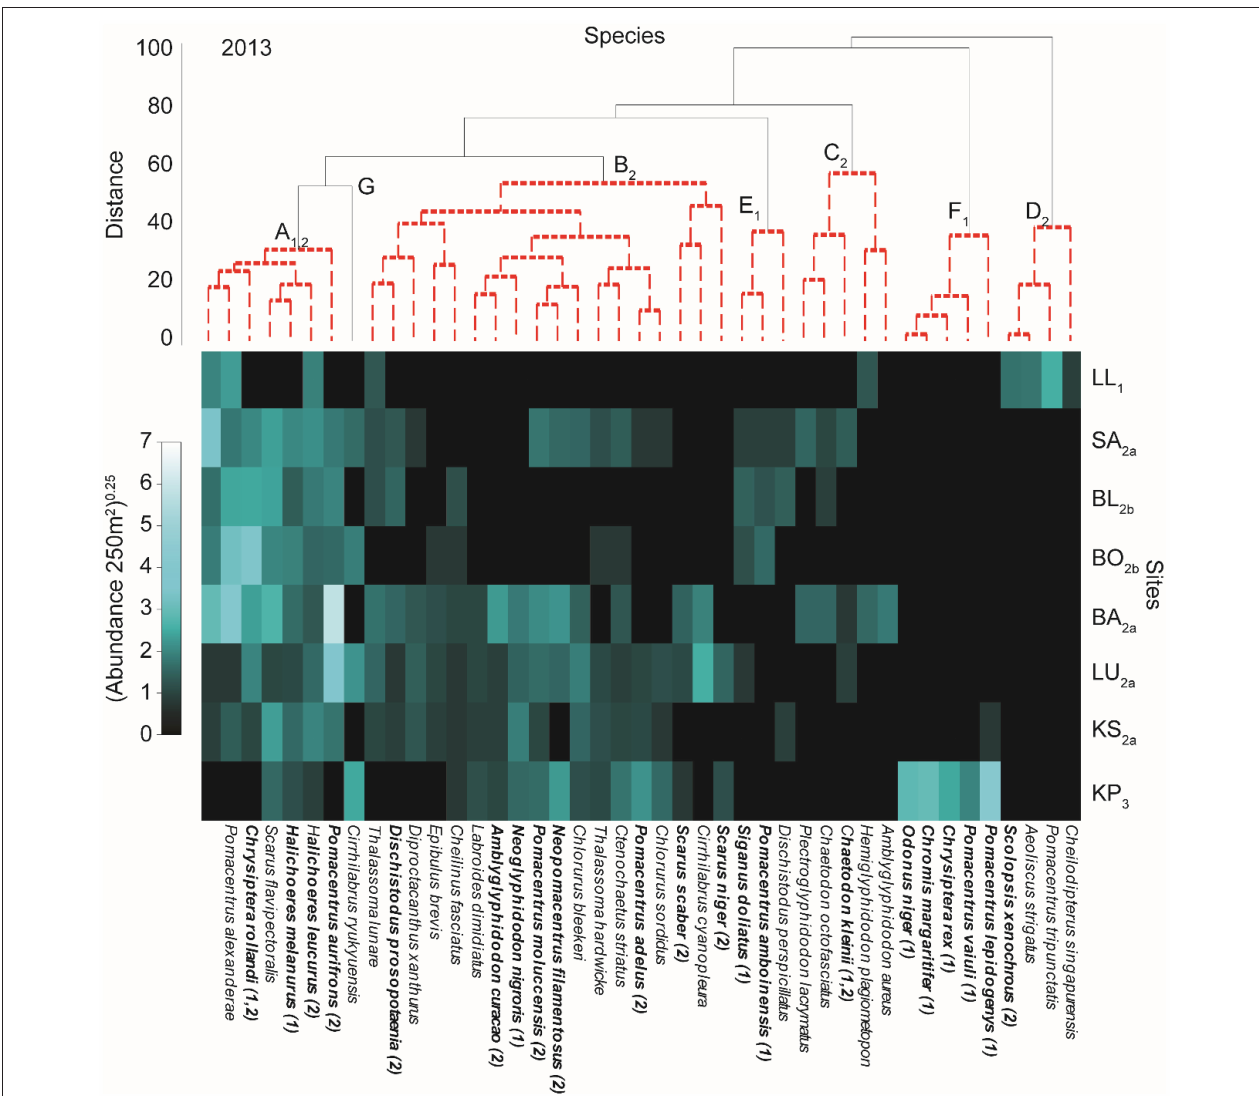
FIGURE 3 | Shade plot of relative species abundances in 2013. Results of cluster analysis showing significant groups (SIMPROF test) of species (capital lettering on species dendrogram and indicated with red dotted line) and sites (numbered subscript on site acronyms and identified in Supplementary Figure 1) with relative abundance of fish indicated in the shade plot. Sites are ordered from top to bottom increasing in distance from the mainland ( Figure 1 ). Subscript on species groups indicates a significant relationship with PCs of the benthic PCA (Supplementary Figure 3) as evaluated by multivariate GLM (Supplementary Table 2). Bolded species names indicate a specie that is related to at least one of the two (indicated in parentheses after specie name) benthic PCs. Full results for individual species can be found in Supplementary Table